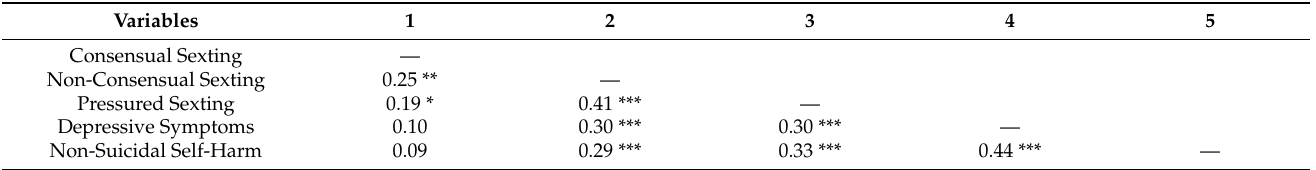
Table 2. Correlations among variables.